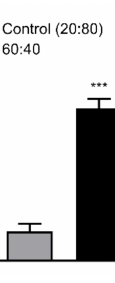
Figure 1. Consumption of the Control 20:80 and 60:40 whey:casein formulation in non-deprived mice during a 2-h episodic exposure of simultaneously presented diets. *** p ≤ 0.001.